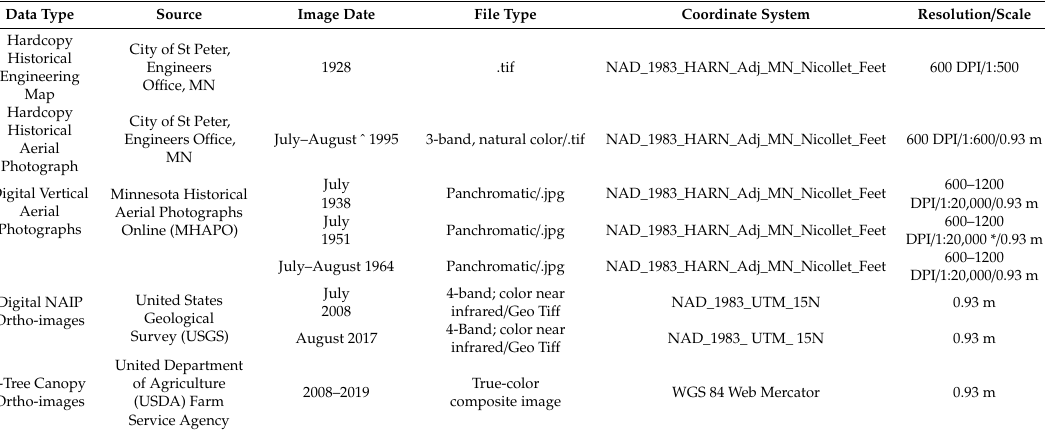
Table 1. Photographic images and map datasets.